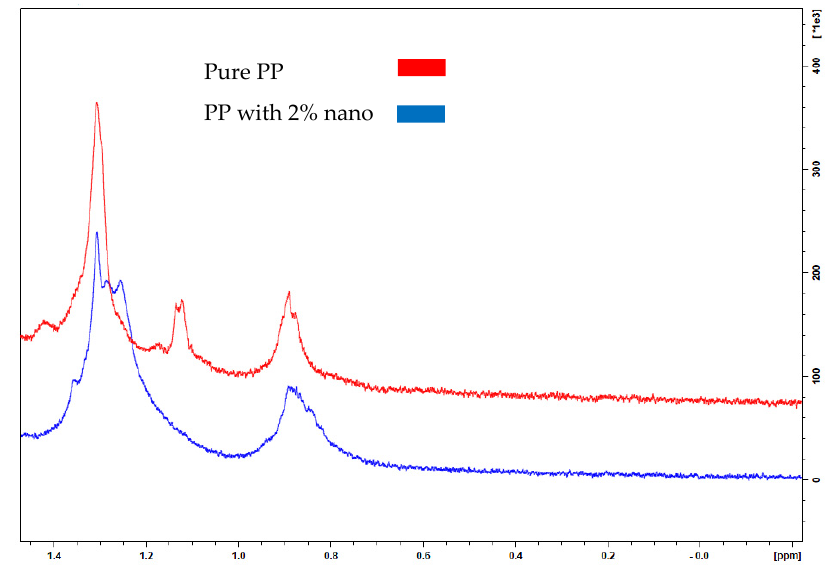
Figure 2. NMR analysis for PP pure and PP nanocomposites with nano-CaCO 3 2% wt.